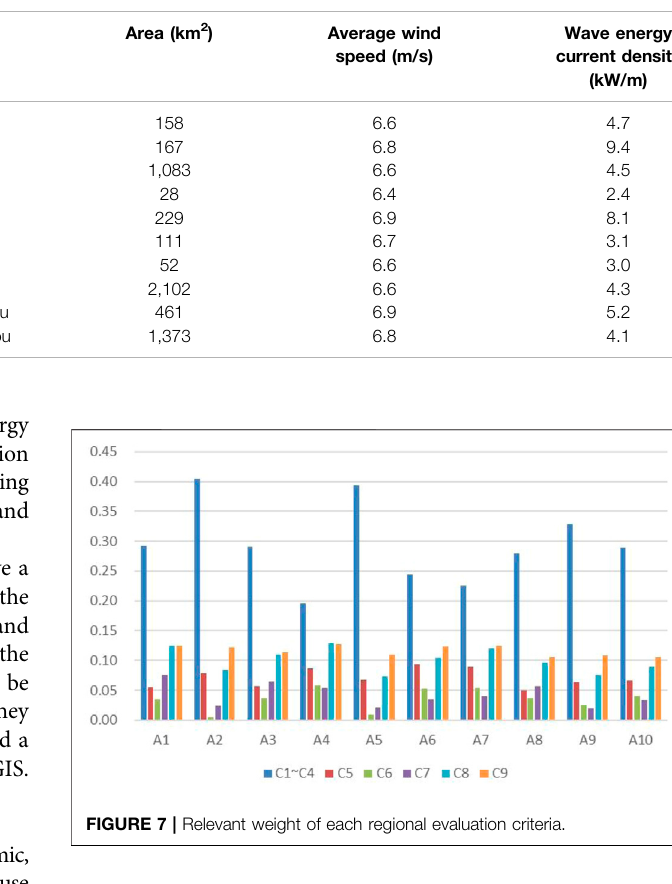
TABLE 3 | Characteristics of COWWF zoning in Zhejiang Province.